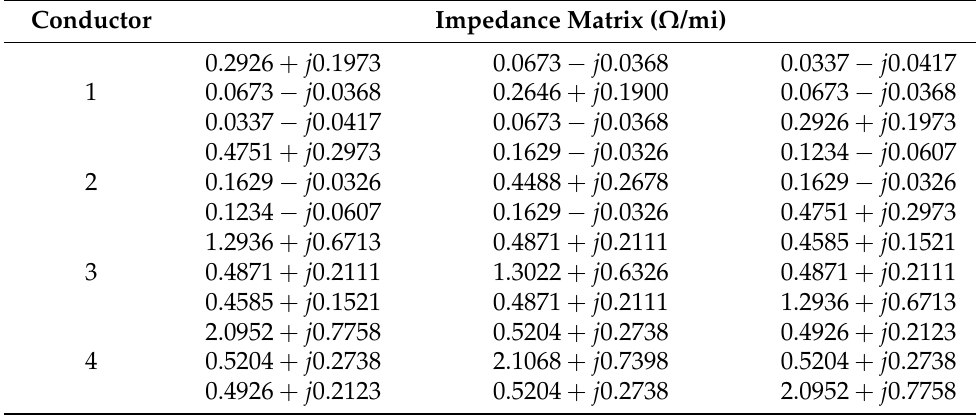
Table 5. Impedance matrix for the type of conductors in the IEEE 37-bus test